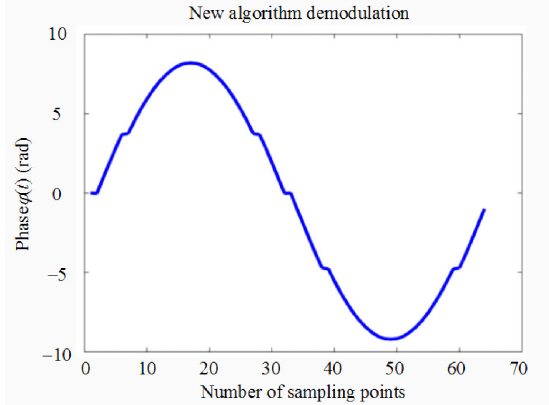
Fig. 6 Flow chart of new algorithm.